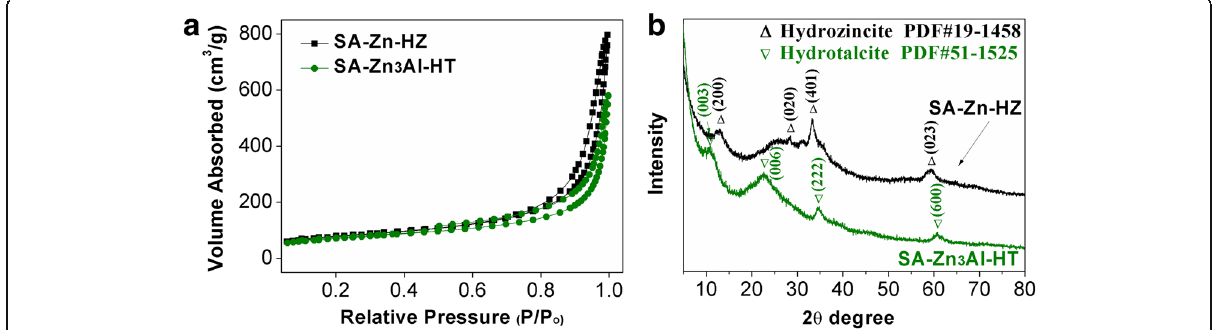
Fig. 3 N 2 adsorption-desorption isotherms ( a ) and XRD patterns ( b ) of SA-Zn-HZ and SA-Zn 3